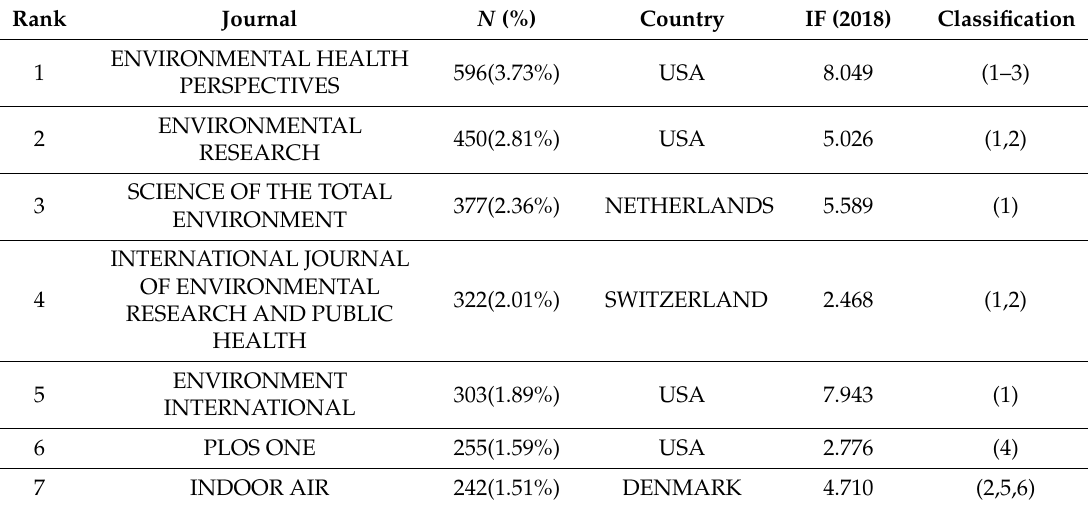
Table 1. The top 10 journals of research on air pollution and